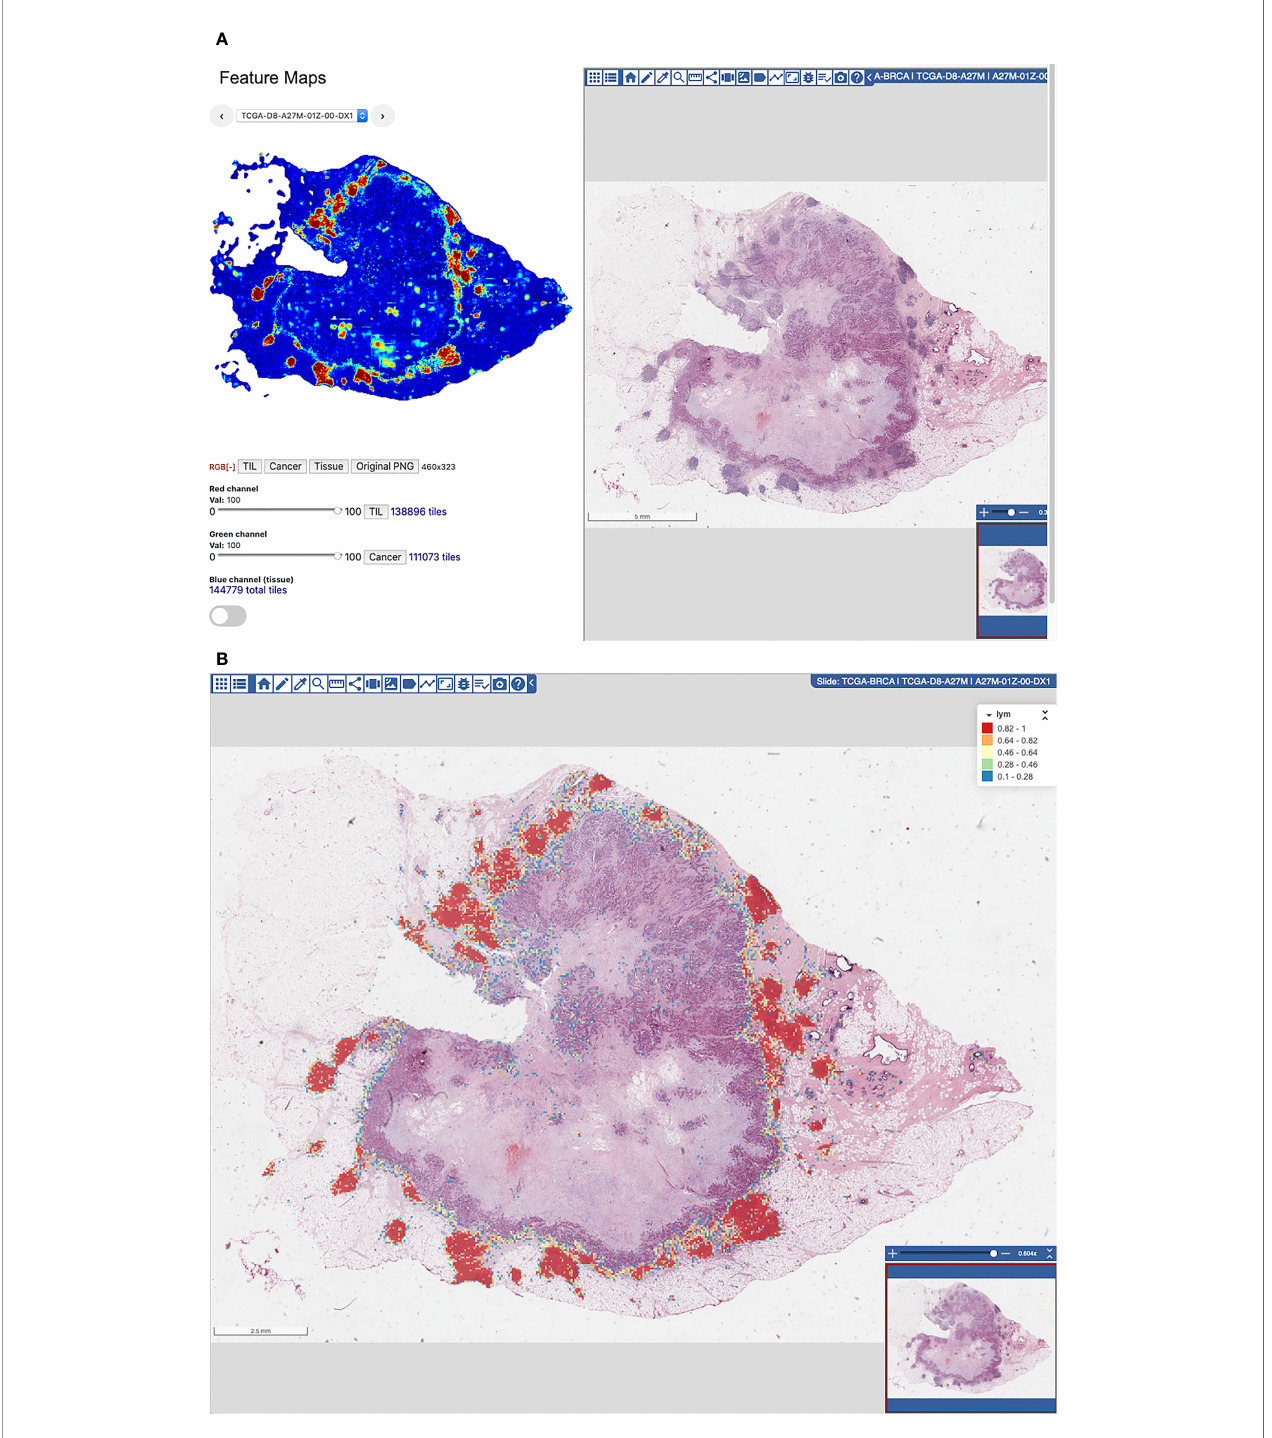
FIGURE 5 | (A) FeatureMap along with a view of the tissue image. (B) Heatmap viewer and editor for viewing of heatmaps on full-resolution WSIs and for fi ne-grain re-labeling of patches to generate additional training